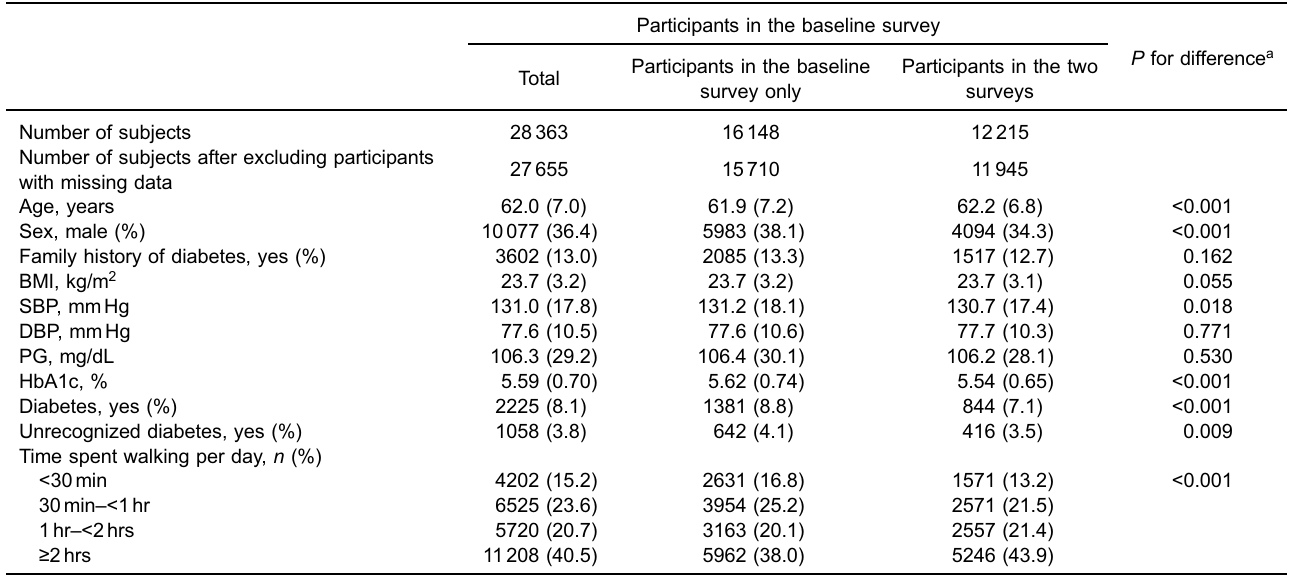
Table 6. Baseline characteristics of study participants who participated in the 5-year survey and those who did not